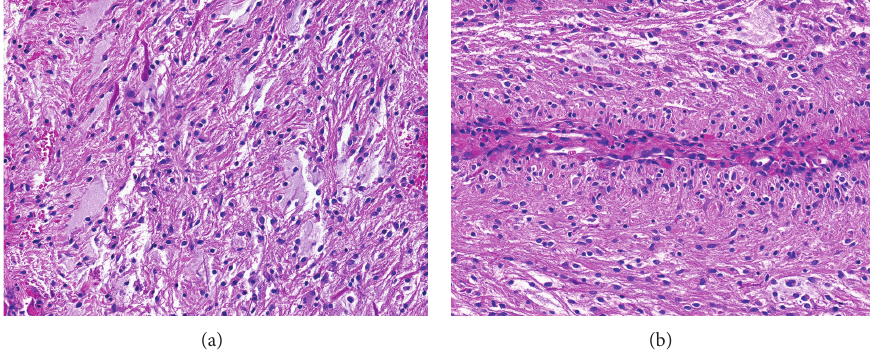
Figure2:(a)ThetumorconsistsofpiloidcellsandshowsabundantmucinandRosenthalfibers(upperleft)(H&Estain;originalmagnification 200x). (b) A few perivascular pseudorosettes were noted, here in longitudinal section (H&E stain; original magnification